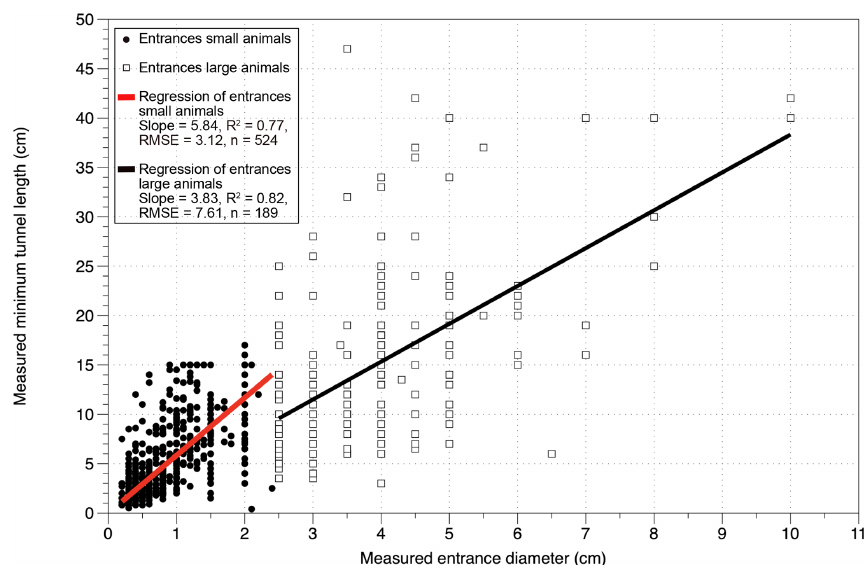
Figure 4. Linear regressions of the correlation between measured entrance diameter and measured minimum tunnel lengths for the groups of large animals and small animals. The regressions are forced through 0 and are calculated from the data of 2018. Entrances of large animals are defined as entrances ≥ 2.5cm diameter; entrances of small animals are of diameters <